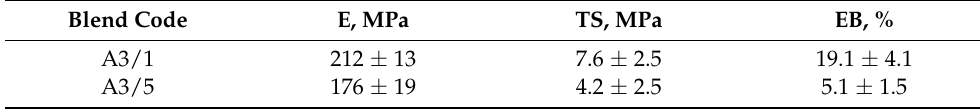
Table 13. Tensile properties of A3/1 and A3/5